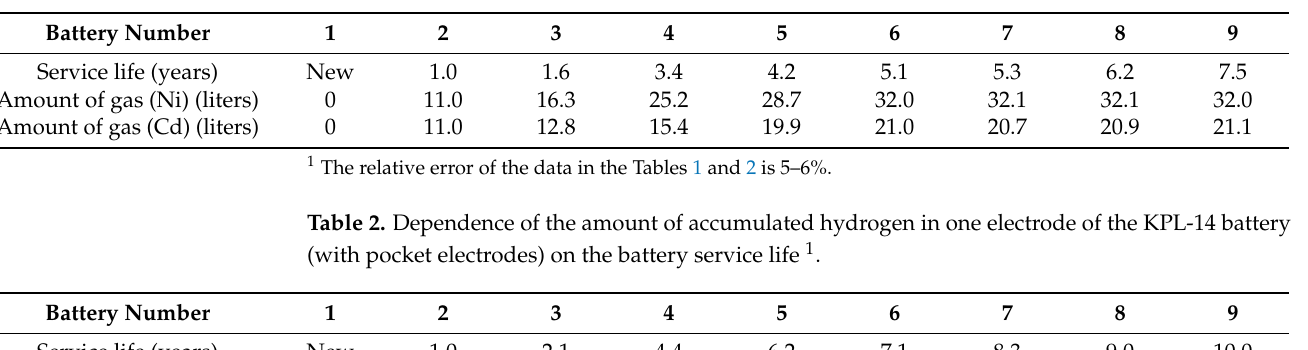
Table 1. Dependence of the amount of accumulated hydrogen in one electrode of the KSL-15 battery (with sintered electrodes) on the battery service life 1 .